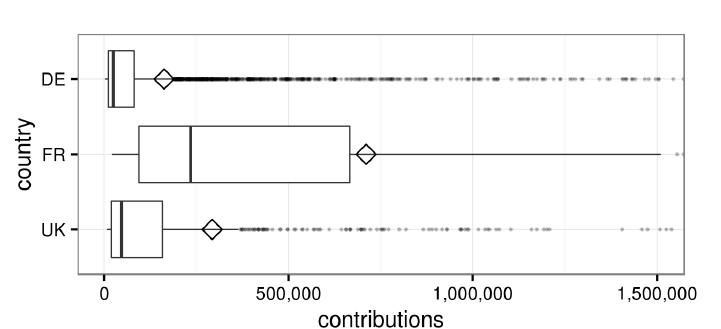
Figure 2. Distributions of